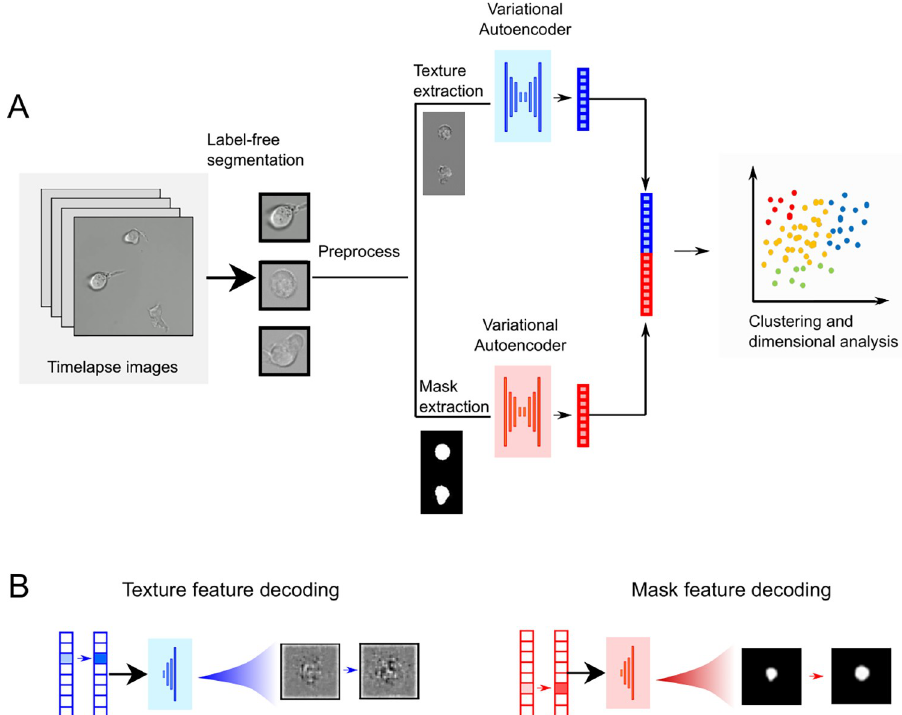
Fig 1. Description of the UPSIDE workflow. (A) Single cells are segmented directly from brightfield images and deep learning UNET architecture to predict synthetic fluorescent images [23]. Segmented cells are then pre-processed to generate separate mask and texture images, which are then used to concurrently train two variational autoencoders (VAEs). The shape and texture encodings learnt by these two VAEs are then concatenated and used for downstream data analysis. (B) Encoded latent vectors are then decoded into a shape and texture image to aid the interpretation of the encoded